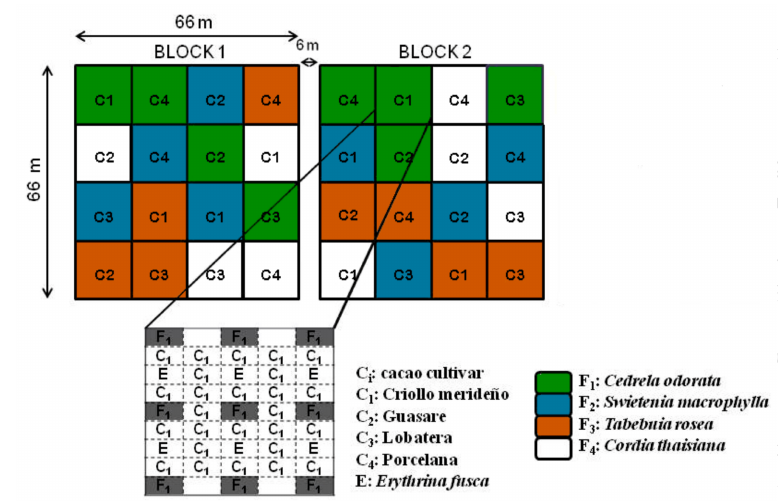
Figure 1. Diagram representing the blocks of treatments at Judibana farm. The lower figure shows spatial distribution of timber trees and cacao plants in each plot (modified from Jaimez et al.